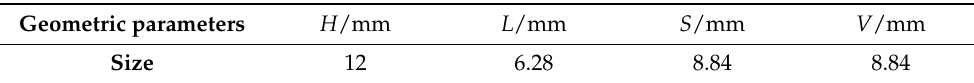
Figure 1. Geometric parameters of V − shaped foldcore unit cells. Table 1. Dimensions of unit